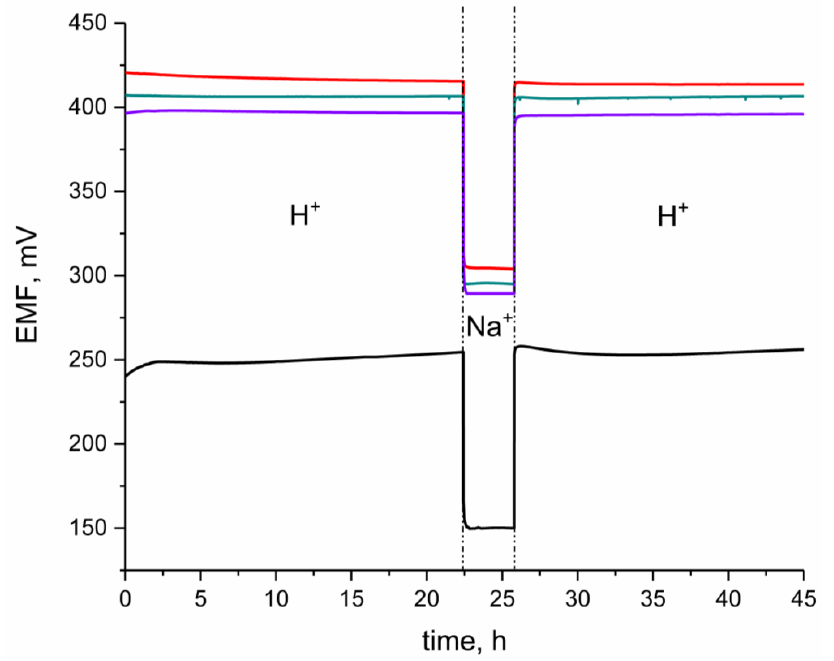
Figure 7. Water-layer test for GC/hIrO 2 /H + -ISM (red line), GC/hIrO 2 +NTs/H + -ISM (green line), GC/hIrO 2 +NTs+POT/H + -ISM (purple line) and GC/H + -ISM (black line) electrode. The test was con- ducted in the buffer solution of pH 3 (primary ion: H + ) and 0.1 M NaCl (secondary ion: Na + ). 318